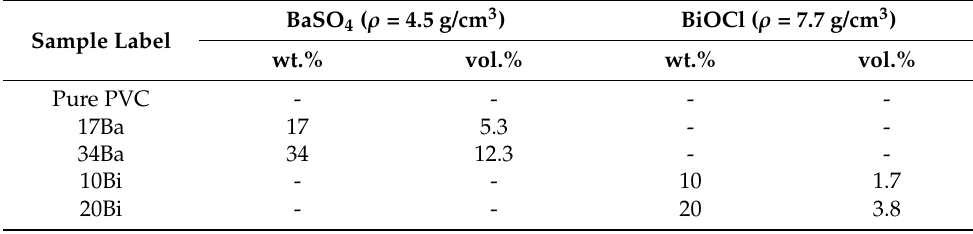
Table 1. Composition of prepared